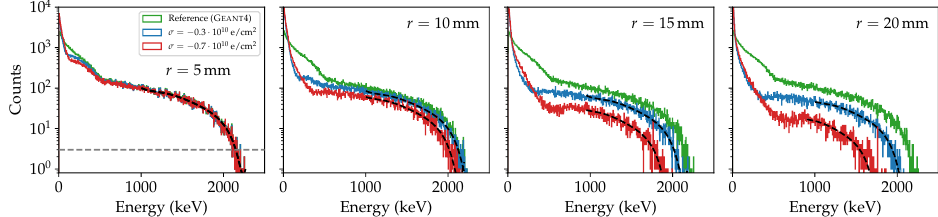
Figure 20. Distribution of E true the simulated 90 Sr events at selected radial positions. The E obs signal propagation in the presence of negative surface charges of σ = spectra were fit with a seventh-order polynomial (black dashed lines) and the intersection with a fixed value was determined.